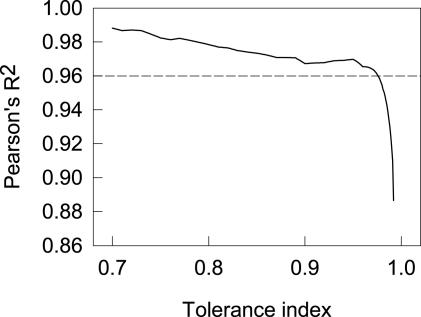
The Experimentally Determined Relative Recombination Tolerance of Five MSV Genomic Regions Is Highly Correlated with Values Inferred from NatureWe used the quadratic regressions presented in Figure 2 to derive experimental estimates of similarly tolerable degrees of RID in the five genomic regions over a range of Ti values between 0.99 and 0.70 (290 values at 0.01 intervals). Using a range of Ti values avoids any biases that might occur due to inadvertently choosing particularly poor/favourable Ti values for estimating similarly tolerable degrees of RID from the experimental data. For example, the set of similarly tolerable degrees of RID calculated when Ti = 0.9 is 15.3%, 8.3%, 2.7%, 3.3%, and 3.8% for the SIR, MP gene, CP gene, LIR, and Rep gene, respectively. Each of the 290 sets of values thus determined was linearly regressed against the set of values for the maximum tolerable RID inferred for the same five regions from an examination of natural recombinants (15.0%, 7.7%, 3.2%, 5.4%, and 3.9%, for SIR, MP, CP, LIR, and Rep, respectively). R
2 values determined for these 290 regressions are plotted against their corresponding Ti values (solid line). The correlation is significant (broken line = R
2 value corresponding to a p-value < 0.01) over the Ti range 0.95–0.7 (Pearson's R
2 > 0.96, p < 0.01; Spearman's rho = 0.9, p = 0.037).